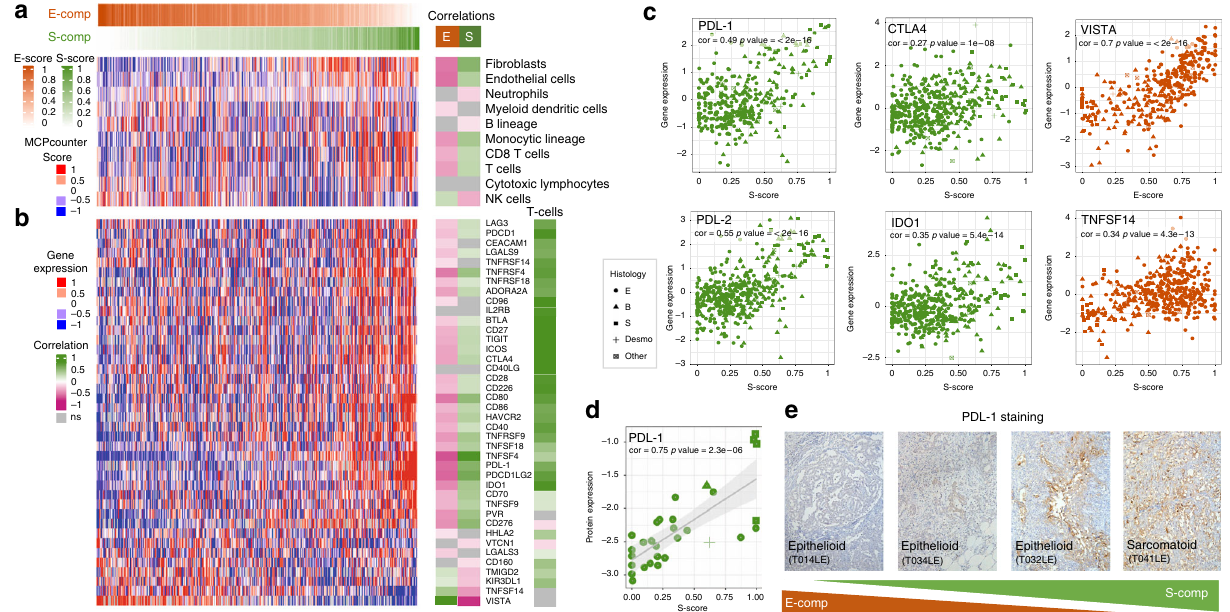
Fig. 5 Speci fi c immune landscape. a , b Heatmaps showing quanti fi cation of immune and stromal populations computed by MCP-counter from transcriptomic data ( a ) and immune checkpoint (ICK) gene expression ( b ), along E-comp and S-comp. The lateral red-green heatmap displays correlation coef fi cient values between the corresponding features and the E-score or S-score and between ICK and the T cell in fi ltration score. Non-signi fi cant correlations ( P value > 0.05, Pearson ’ s correlation test) are represented in gray. c , d Gene expression plots for different immune checkpoints ( PDL1 , PDL2 , CTLA4 , TNFSF14 , and VISTA ) and one checkpoint modulator ( IDO1 ) ( c ) and the plots of PDL-1 protein expression (RPPA data) ( d ) vs. the E -score or S -score. For each plot, the correlation and P value are shown (Pearson ’ s correlation test). The point shapes correspond to the different MPM histologies: epithelioid (E), biphasic (B), sarcomatoid (S), and desmoplastic (Desmo). e Immunohistochemical staining for PDL-1 in four samples along E-comp and